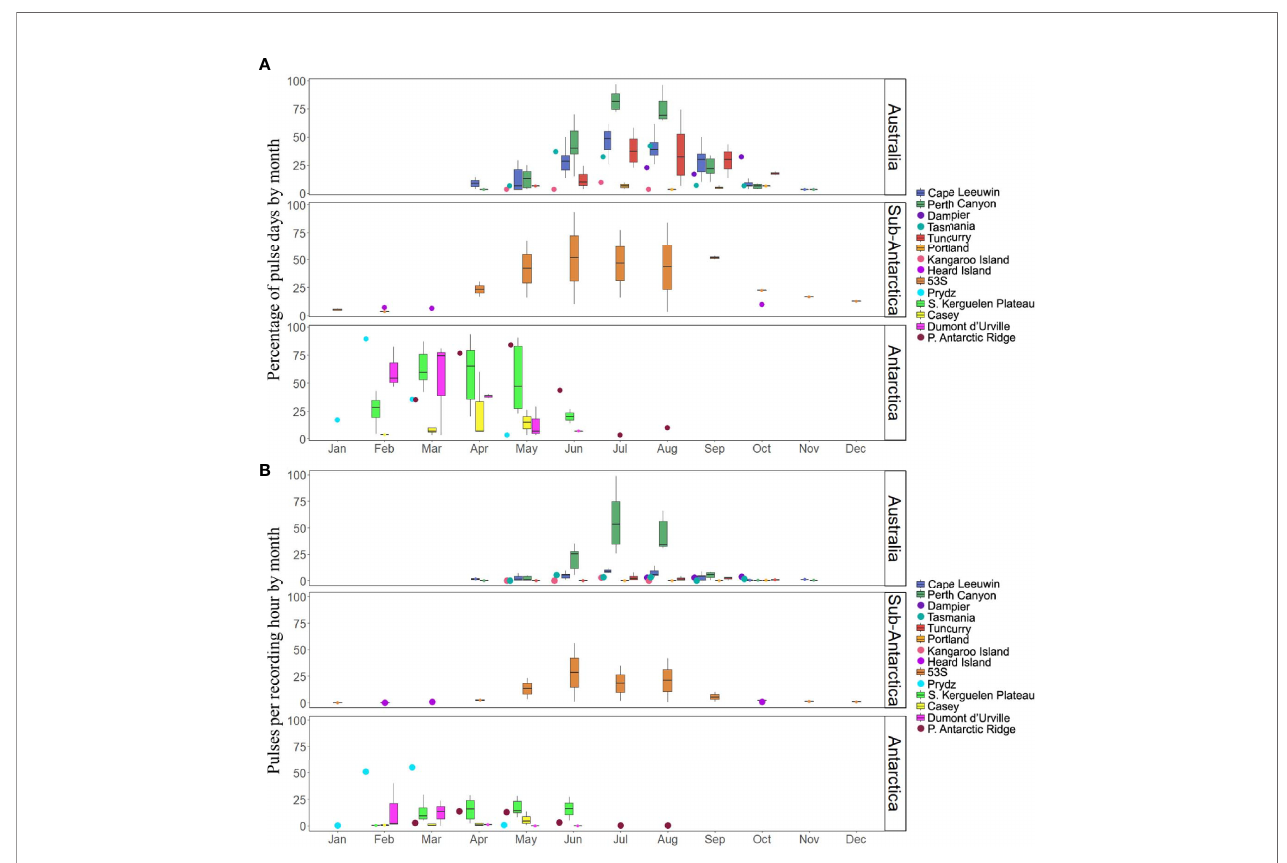
FIGURE 4 | Monthly boxplots of fi n whale acoustic presence. (A) The percentage of fi n whale pulse-days to recording-days by month at each sample site, combined over sample years and (B) the fi n whale pulse rate (i.e., pulses detected per recording-hour) by month at each sample site, combined over sample years. Boxplots display the median, interquartile range, minimum and maximum values. Scatter points display values at sites with only one recording